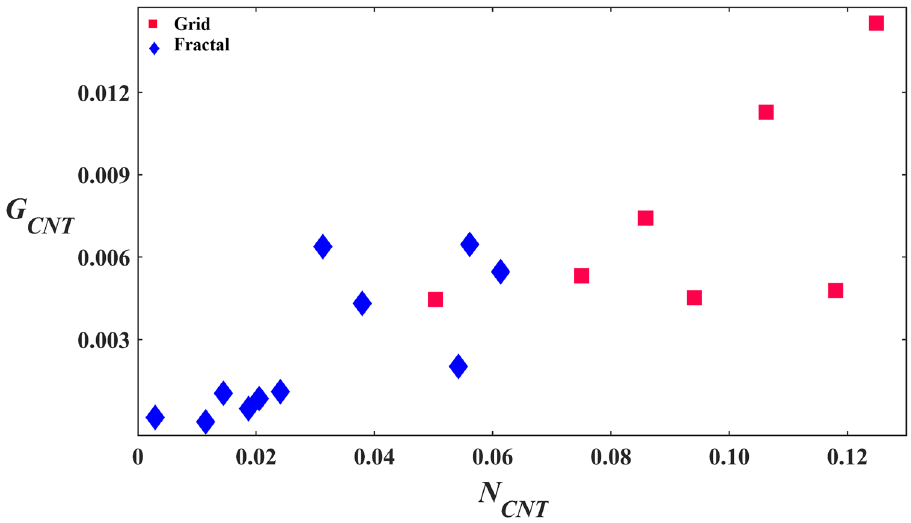
Figure 6. Study of the relationship of G CNT with N CNT for the grid and fractal electrodes. Scatterplot of G CNT versus N CNT for the grids (red) and fractals